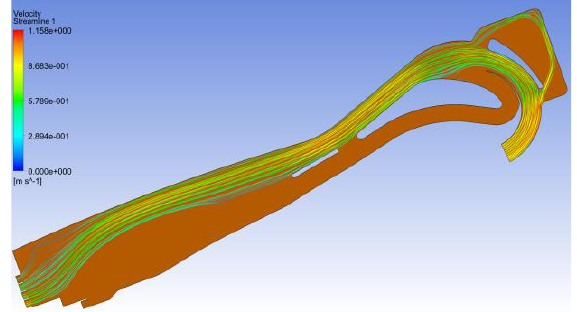
Figure 7. mathematical model of the lake.